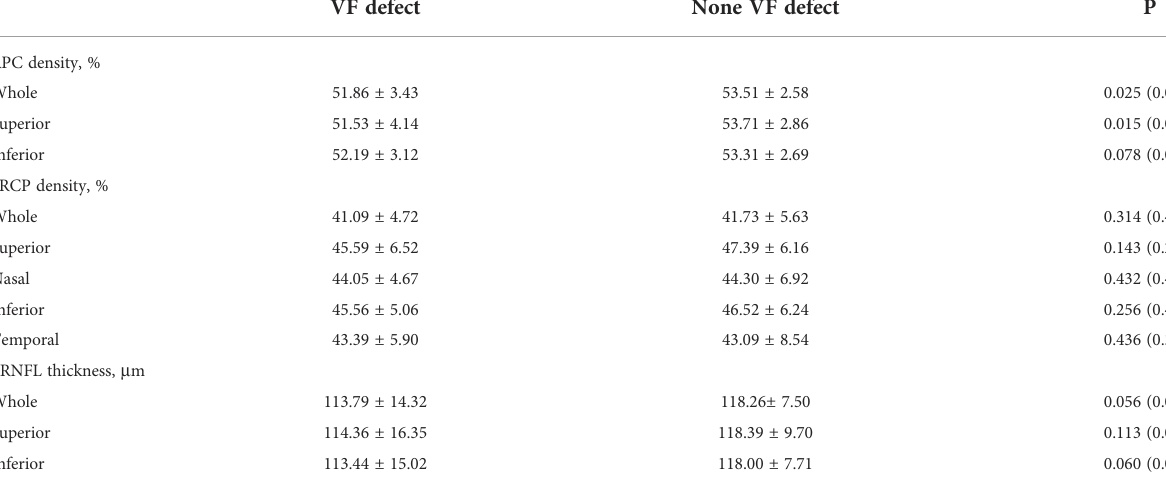
TABLE 3 Alteration of retinal capillary density and peripapillary RNFL